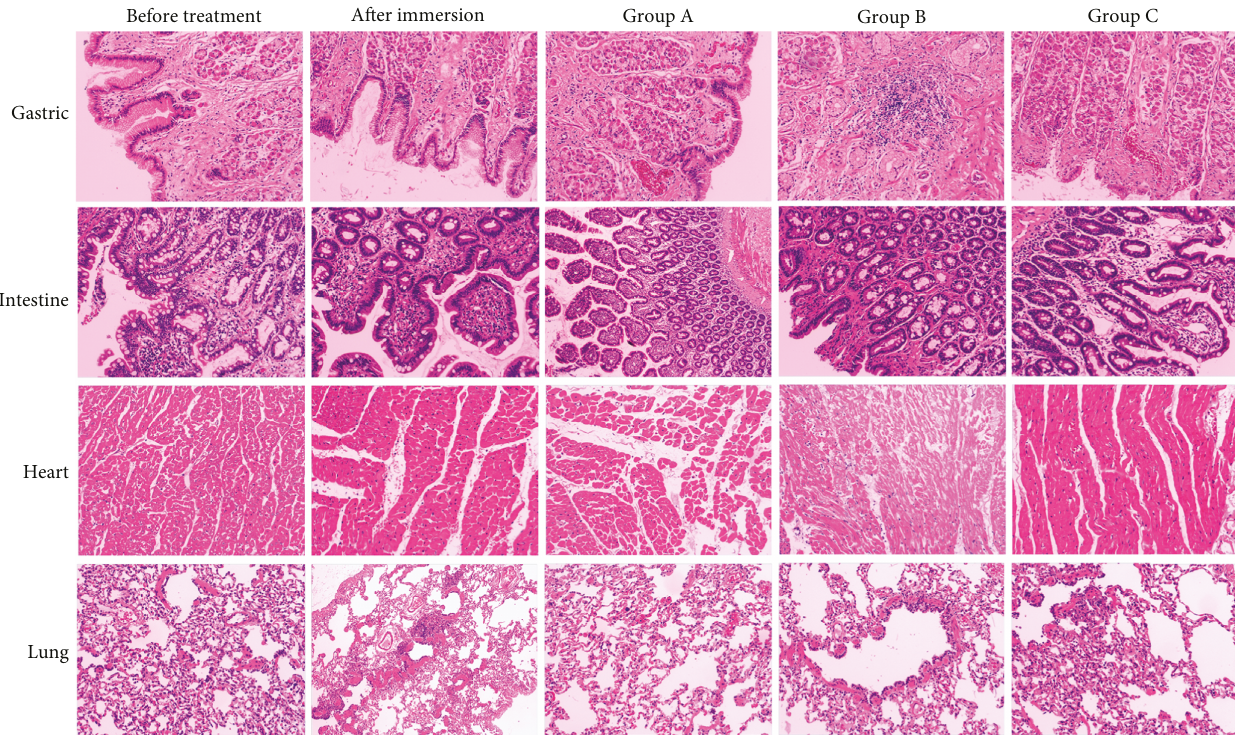
Figure 3: H-E staining of the stomach, small intestine, heart, and lung tissue in dogs with di ff erent treatments at each time point (100x). Dogs were euthanized at 2h after open abdominal injury, 3h after the dogs were pulled up from seawater, 2h after delayed lavage (group A), 2h after timely lavage (group B), and 2 h after timely lavage with the device (group C). The lung, stomach, small intestine, and heart tissues were harvested immediately after the dogs were euthanized. After fi xation, para ffi n embedding, sectioning, and HE staining, the pathological changes of the tissues were observed under a microscope.